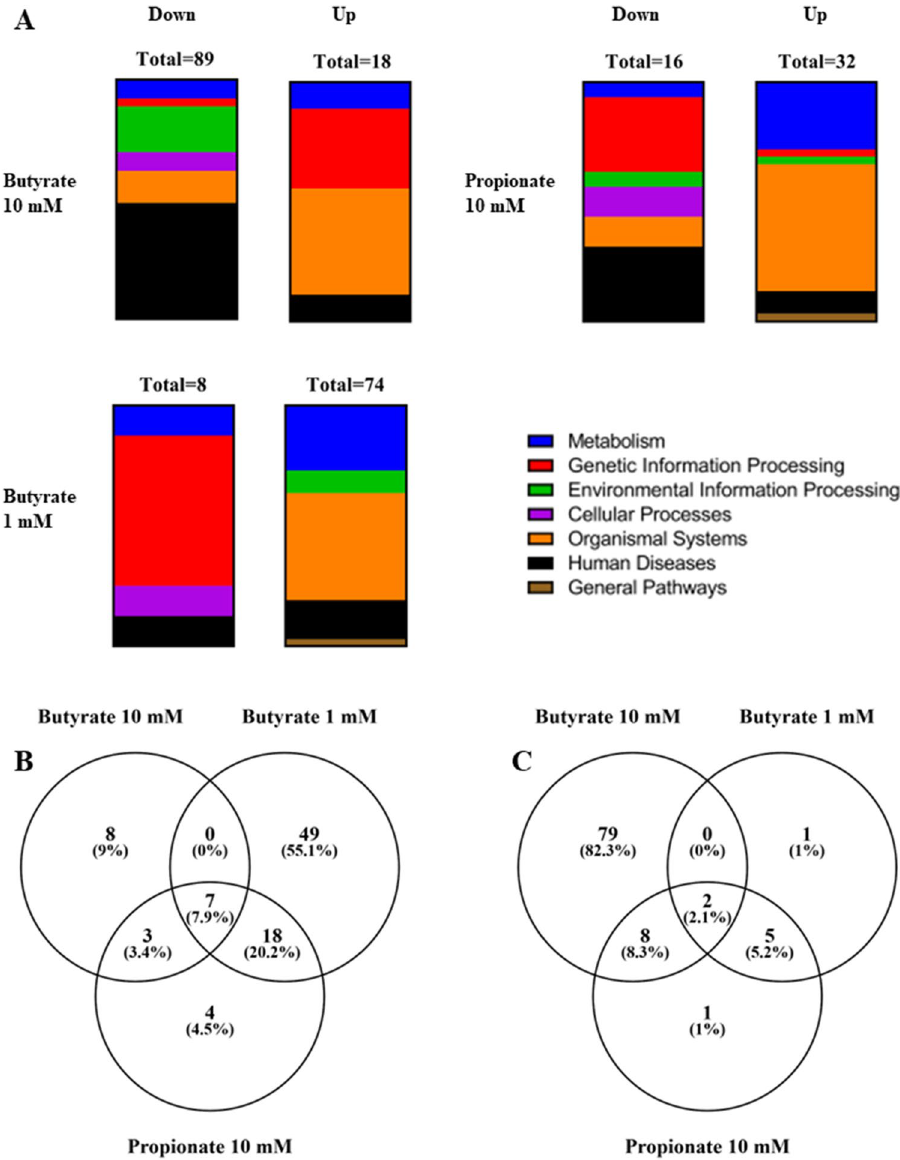
Figure 4. Differentially regulated pathways ( P < 0.05, FDR < 0.25) in induced pluripotent stem cell derived intestinal epithelial cell layers exposed to 1 or 10 mM butyrate or 10 mM Propionate for 24 h. ( A ) vertical slice graphs showing the distribution of the up- or downregulated pathways over six KEGG categories. ( B ) Venn diagram showing the upregulated pathways, and ( C ) Venn diagram showing the downregulated pathways versus the